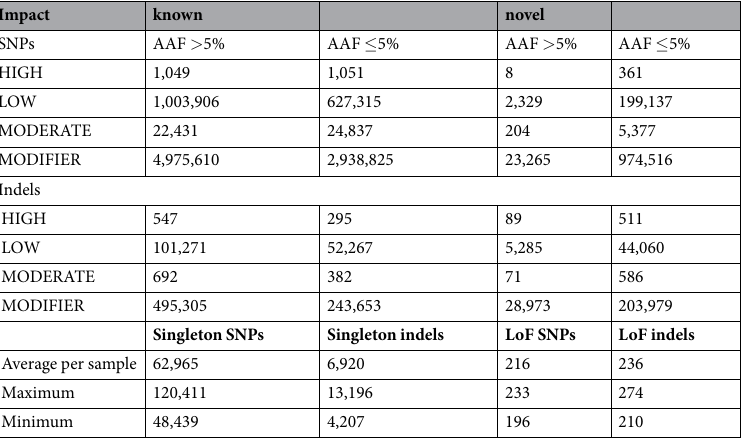
Table 1. Genetic variants discovered from whole genome sequencing on 48 JIA individuals. Number of JIA SNPs and indels classified by predicted functional impacts and alternative allele frequency (AAF). Lower panel summarizes per sample summary on singleton (private mutation) and loss of function (LoF)